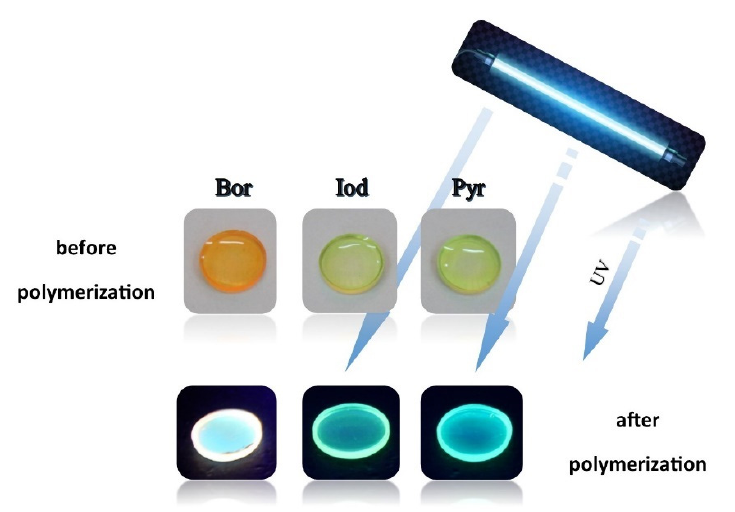
Figure 10. Images of the samples before and after photopolymerization process.